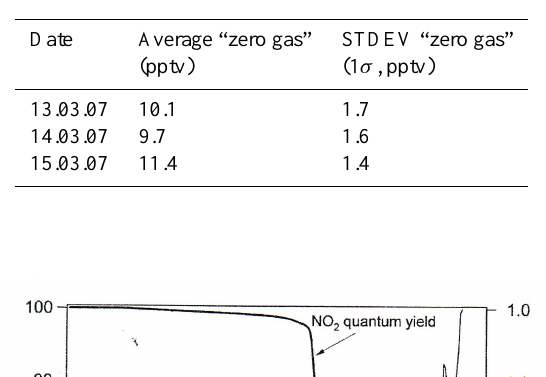
Table 1. Average and standard deviation of zero gas measurements for NO.